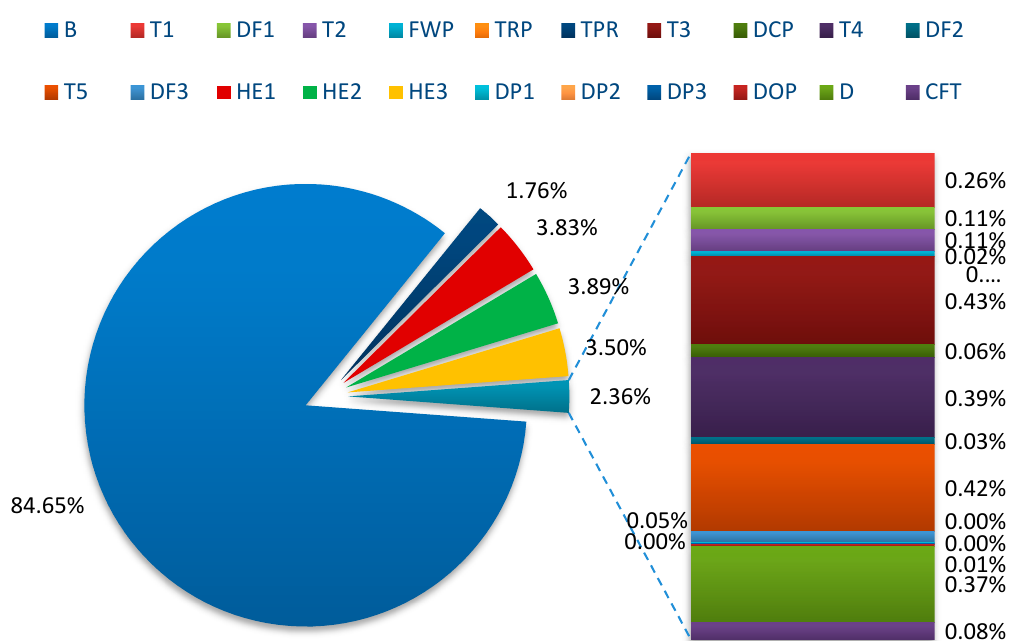
Figure 8. Percentage of each component’s exergy improvement potential to the total.